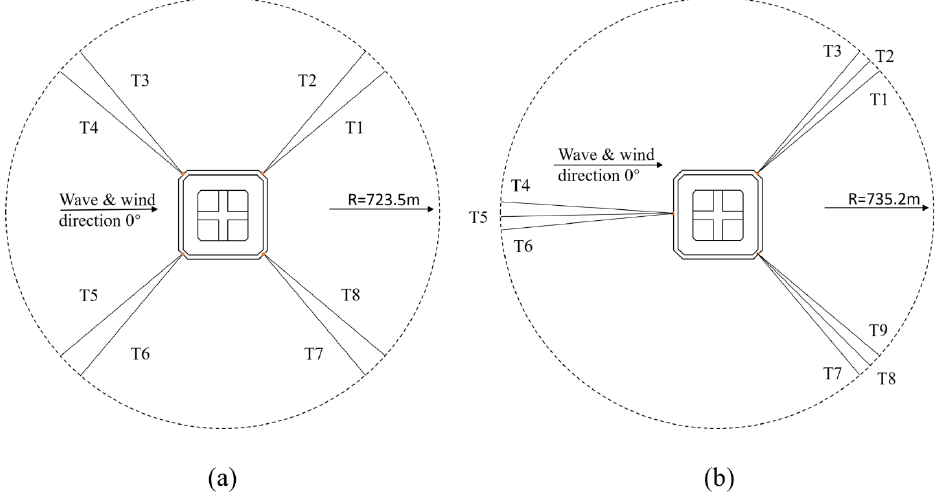
Figure 10. Illustration of mooring systems: ( a ) 4 × 2 mooring system; ( b ) 3 × 3 mooring system.